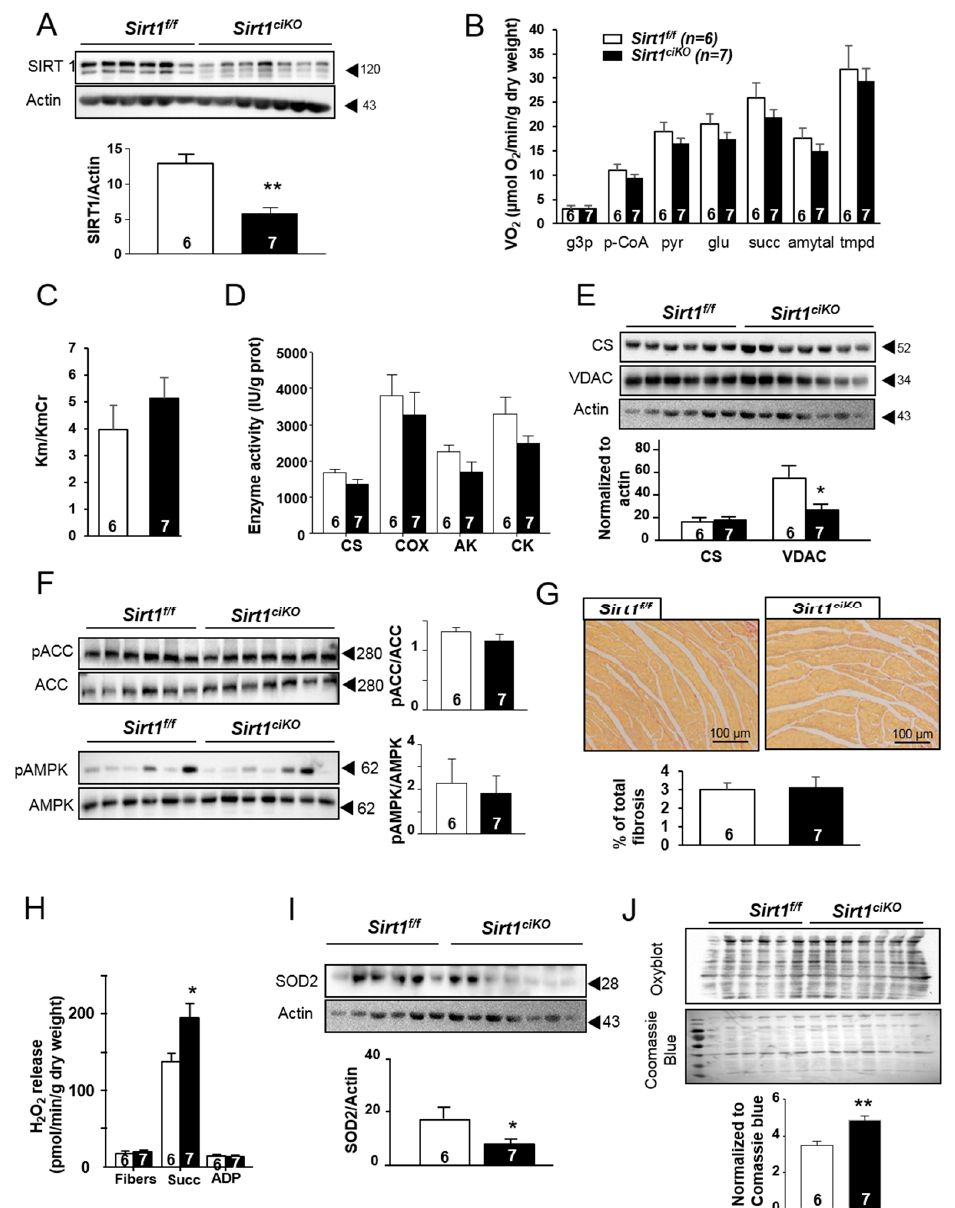
Figure 3. Cardiac mitochondrial phenotype of cardiac-specific knockout mice after 16 weeks of Sirt1 deletion. ( A ) SIRT1 protein content in left ventricle (LV) homogenates. ( B ) Rate of respiration after successive addition of L-glycerol-3-phosphate (4 mM) (g3p), palmitoyl-CoA, and carnitine (100 µM and 2 mM) (p-CoA), pyruvate (1 mM) (pyr), glutamate (10 mM) (glu), succinate (15 mM) (succ), amytal (1 mM), and N , N ’, N ´-tetramethyl-phenylenediamine dihydrochloride (TMPD)-ascorbate (0.5 mM). ( C ) Ratio between Km without creatine and Km with creatine. ( D ) Citrate synthase (CS), cytochrome c oxidase (COX), adenylate kinase (AK), and creatine kinase (CK) enzymatic activities. ( E ) Immunoblotting of citrate synthase (CS) and voltage-dependent anion channel (VDAC) in LV homogenates. ( F ) Immunoblotting of total acetyl-CoA carboxylase (ACC), phosphorylated-ACC (pACC), total AMP-activated protein kinase (AMPK), and phosphorylated-AMPK (pAMPK) in LV homogenates. ( G ) Representative of fibrosis analysis by Sirius red staining of subequatorial heart sections. ( H ) Net rate of H 2 O 2 release by the mitochondrial electron transport chain measured following sequential addition of succinate (5 mM) and ADP (1 mM). ( I ) SOD2 protein content in LV homogenates. ( J ) Carbonylation of LV proteins. ( n = 6 to 7 per experimental group), * p < 0.05; ** p < 0.01 Sirt1 f / f versus Sirt1 ciKO .